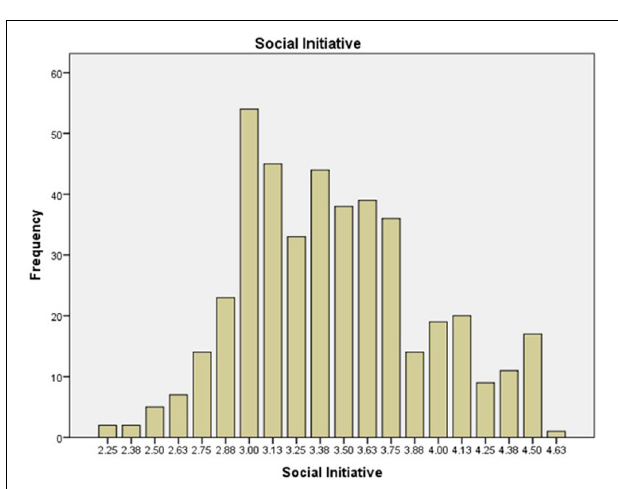
FIGURE 6 | MPQ-SF mean